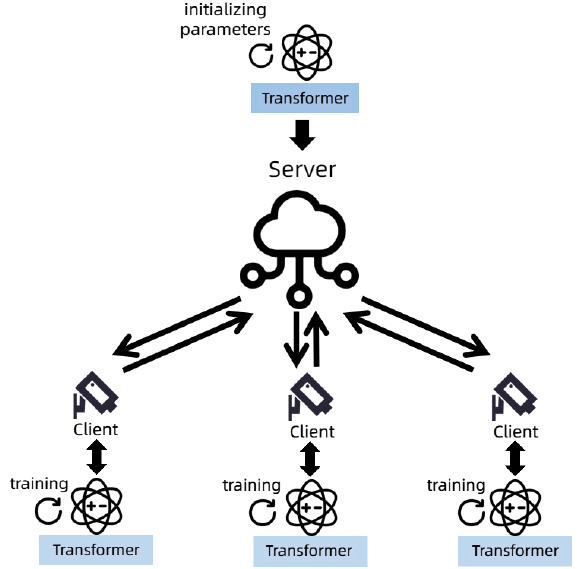
Figure 1. Replacing Traditional Neural Network with